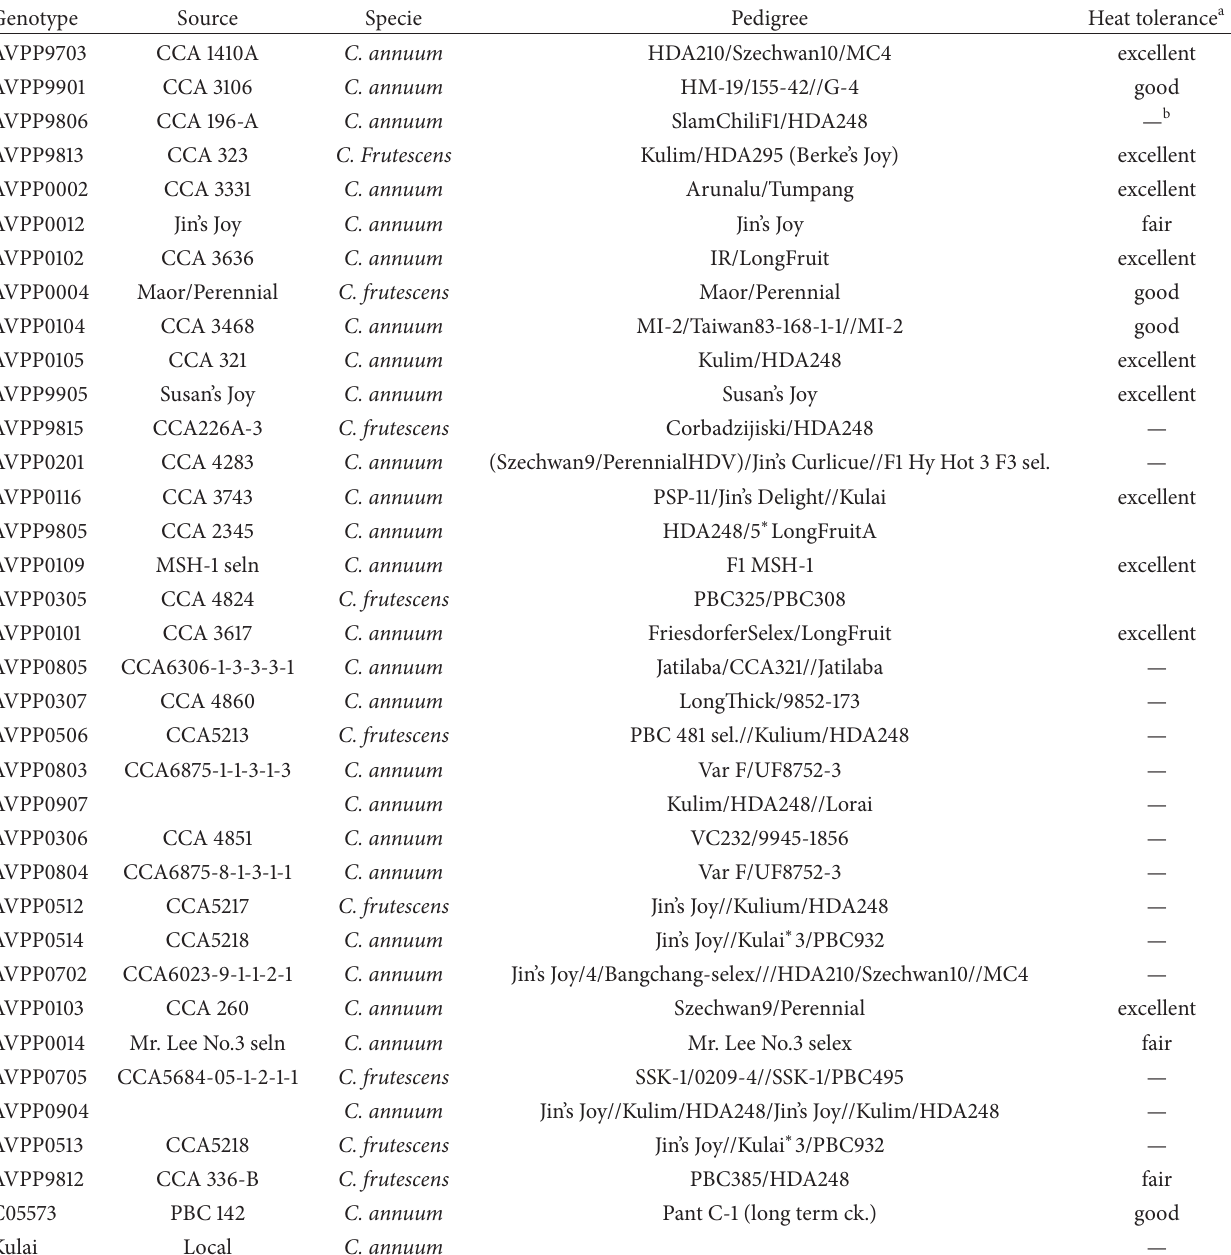
Table 2: List of chili pepper genotypes and their pedigree, specie, and heat tolerance used in this experiment.